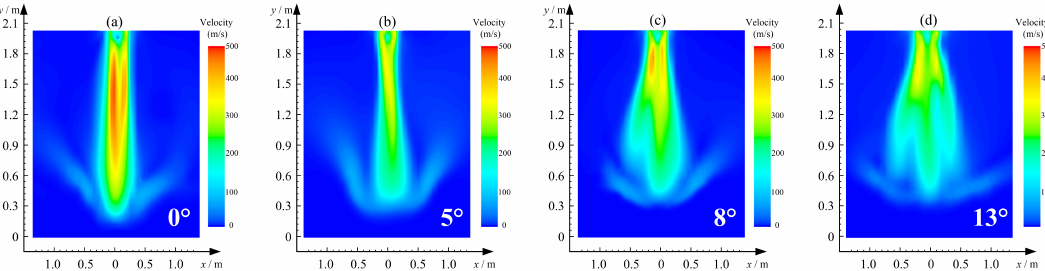
Figure 6. Jet velocity profiles in top-blowing steelmaking with different multi-nozzle oxygen lances.